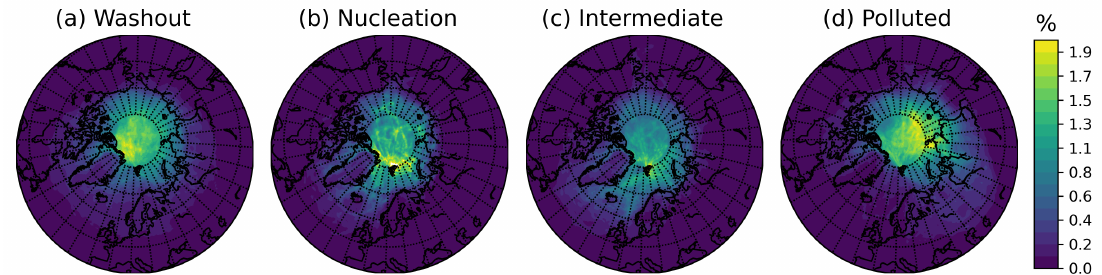
Figure A3. Transport Probability Map [%] for all four cluster groups: ( a ) Washout, ( b ) Nucleation, ( c ) Intermediate and ( d )